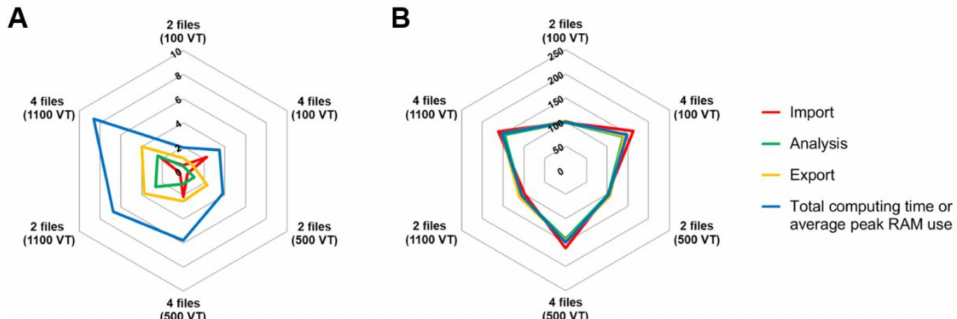
Figure 4. Performance analysis of MPTHub. ( A ) Computing time (in s) and ( B ) RAM peak use (in MB) when processing two or four input data files containing 100, 500, or 1100 valid trajectories (VT). Results are presented as mean values ( n = 3). Table 1. Properties of COOH-PS NPs. Results are presented as mean ± SD values ( n = 3). NPs Coating